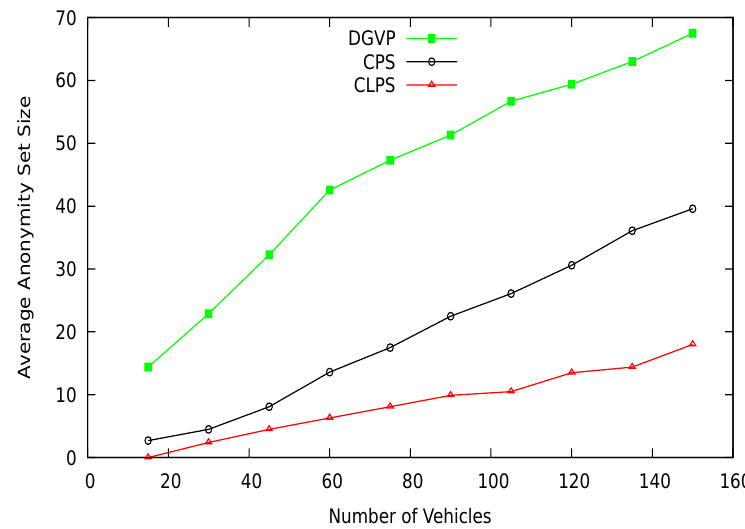
Figure 16. The anonymity of vehicles at different traffic densities.